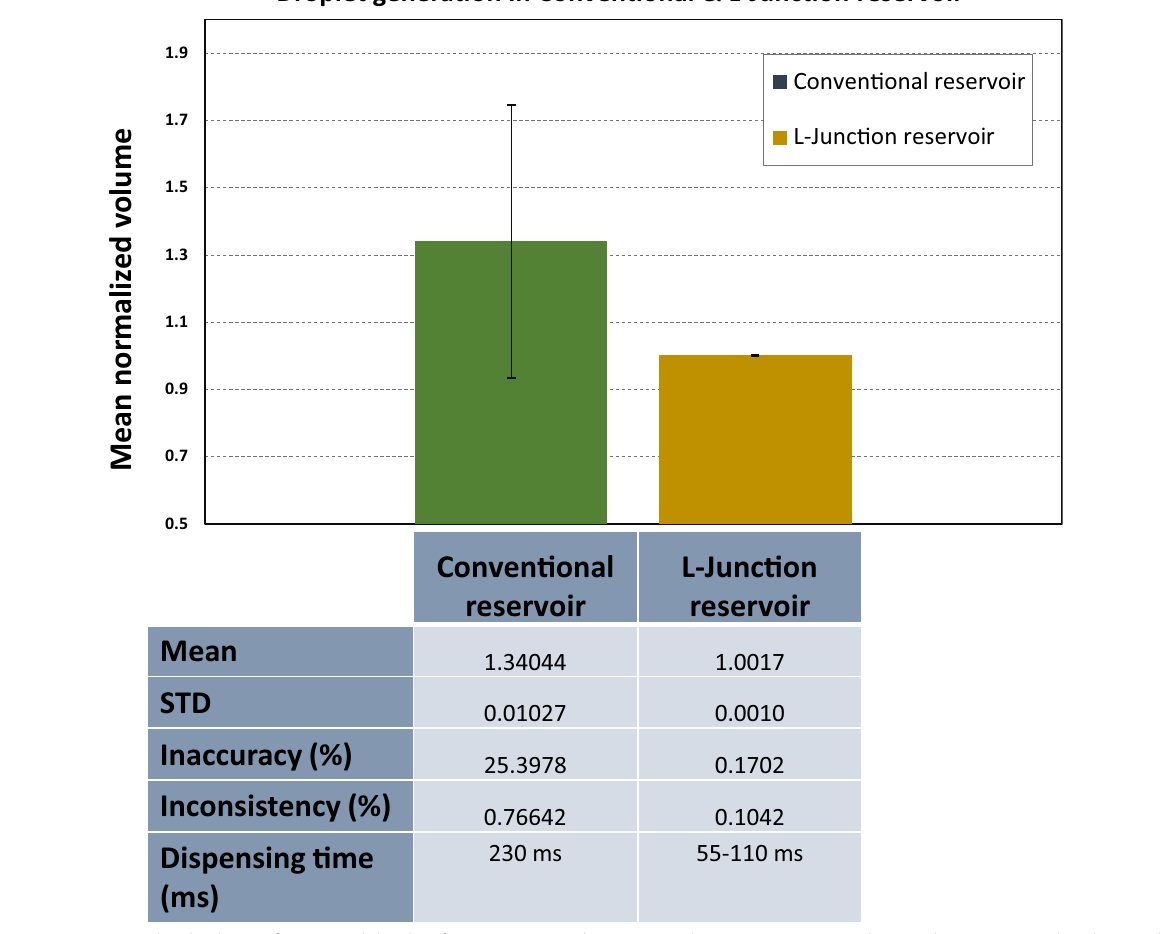
Fig. 3 Mean normalized volume of generated droplets from conventional reservoir and L-junction reservoir. The error bars correspond to the stand- ard deviations. Tabulated values are the summary of tests performed on 10 droplets for both